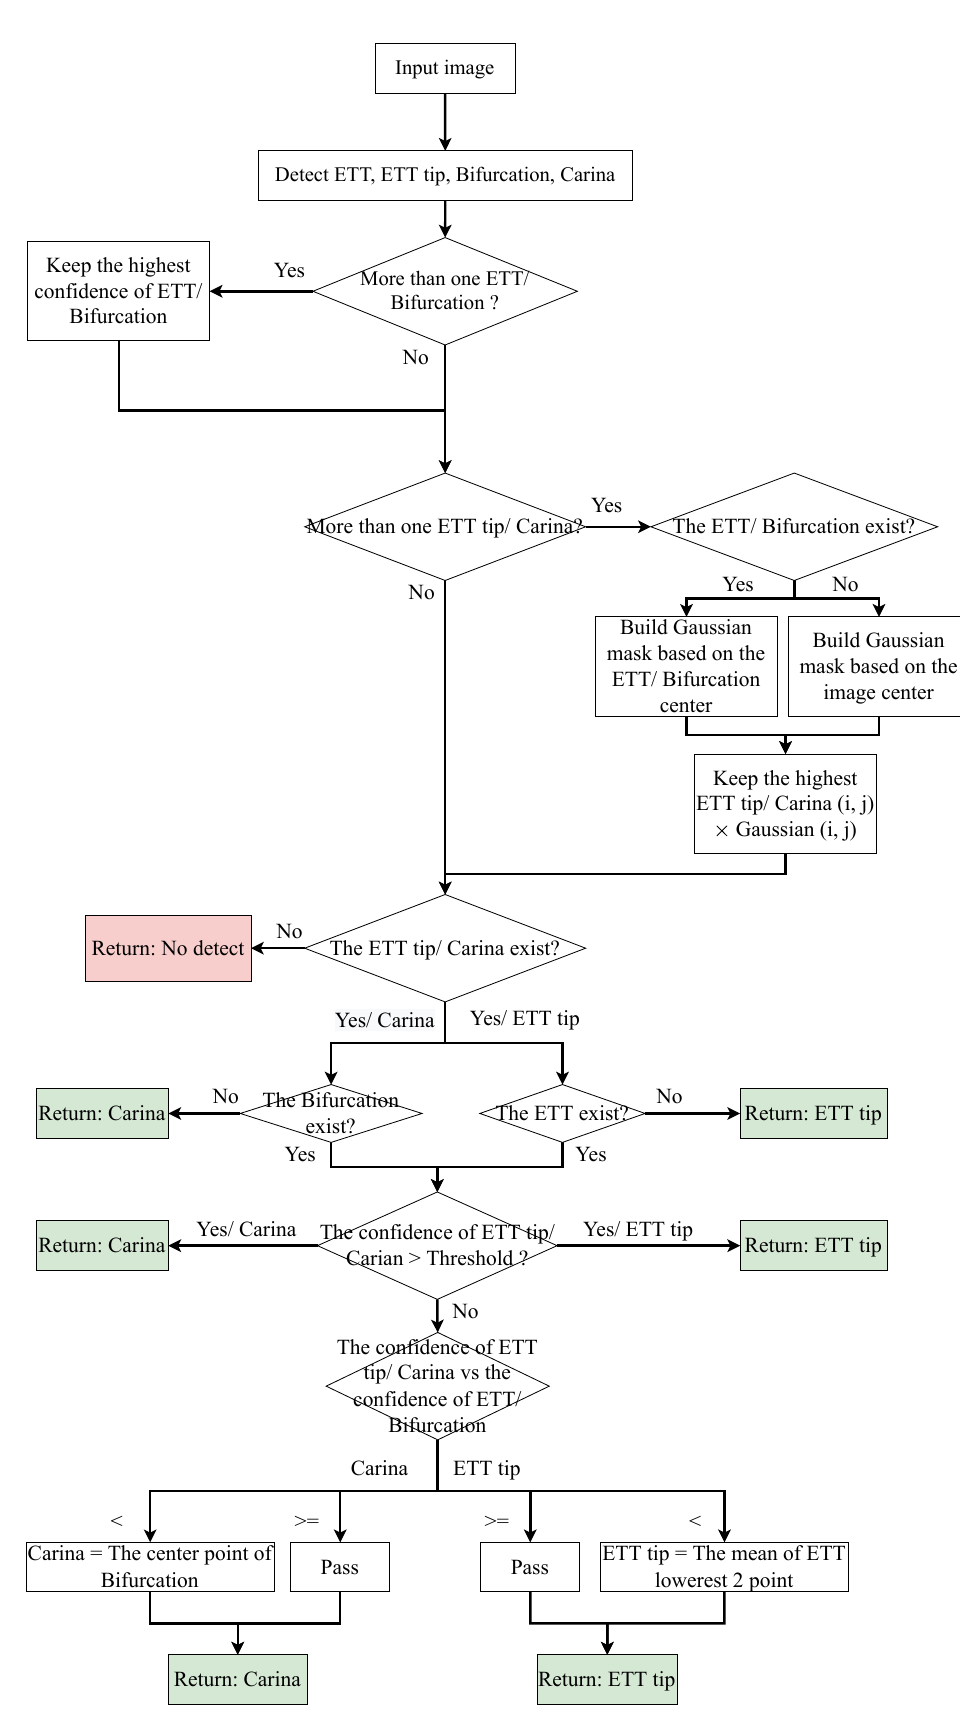
Figure 5. An illustration of